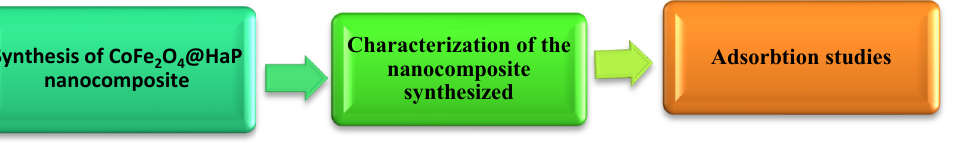
Figure 1. The general diagram of the stages covered in this study.